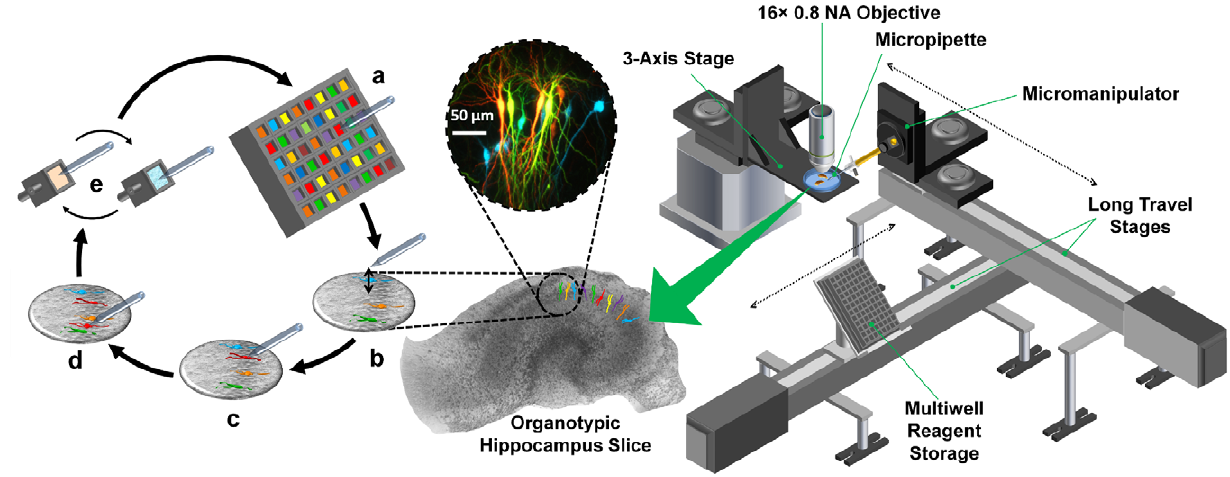
Figure 1. High-Throughput Single-Cell Electroporation System. The sequence of operations and the system are shown on the left and on the right, respectively. (a) The micropipette is front-loaded from a multiwell plate containing reagents, (b) before being rapidly transferred and positioned at a fixed location in the field of view of the microscope objective. (c,d) The three-axis stage holding the slice bath/manipulation chamber moves the sample and bring cells into contact with the stationary micropipette, allowing transfections to be carried out. (e) The system automatically transfers the micropipette tip to a cleaning solution bath as well as a rinsing reservoir where the tip is washed and prepped to sample a different well of the multiwell plate, allowing the cycle to continue. Pyramidal cells depicted in inset were imaged for Cerulean, EGFP, YFP, and tdTomato 24 hours post- transfection.